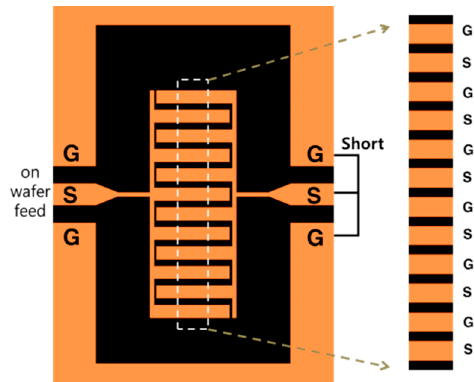
Figure 10. Geometry of the interdigital capacitor (detailed information is in the literature (ref. [9])).